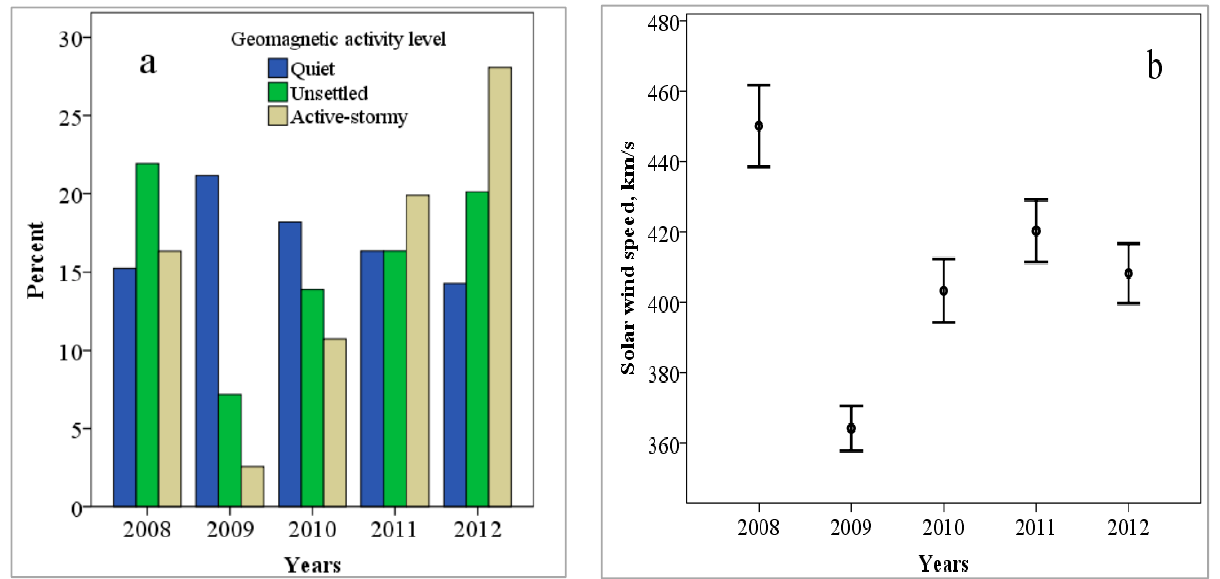
Figure 1. The distribution of GMA levels ( a ) and the mean values ± SE of solar wind speed ( b ). The mean values of HF and HF% (LF/HF) were higher (lower) on the days of CRI > median, but the effect of CRI was non-significant if the linear trend was included in the model. The mean values of HRV variables in Ap, a maximal daily 3-hourly ap (apmax), DST, and SWS quartiles showed higher mean HF and HF% and a lower mean LF/HF if Ap and local A on the previous days were lower than the median. Lower HF% and LF% and a higher VLF% were observed one day after days with a DST over the 75th percentile. On the days of SWS < 25th percentile, lower mean values of logarithmic SDNN, VLF, LF, and LF/HF were observed, and on the days of SWS > 75th percentile, the mean HF% (LF/HF) was lower (higher). Most of these remained after adjusting for the linear trend and the month. The corresponding β coefficients are presented in Figure